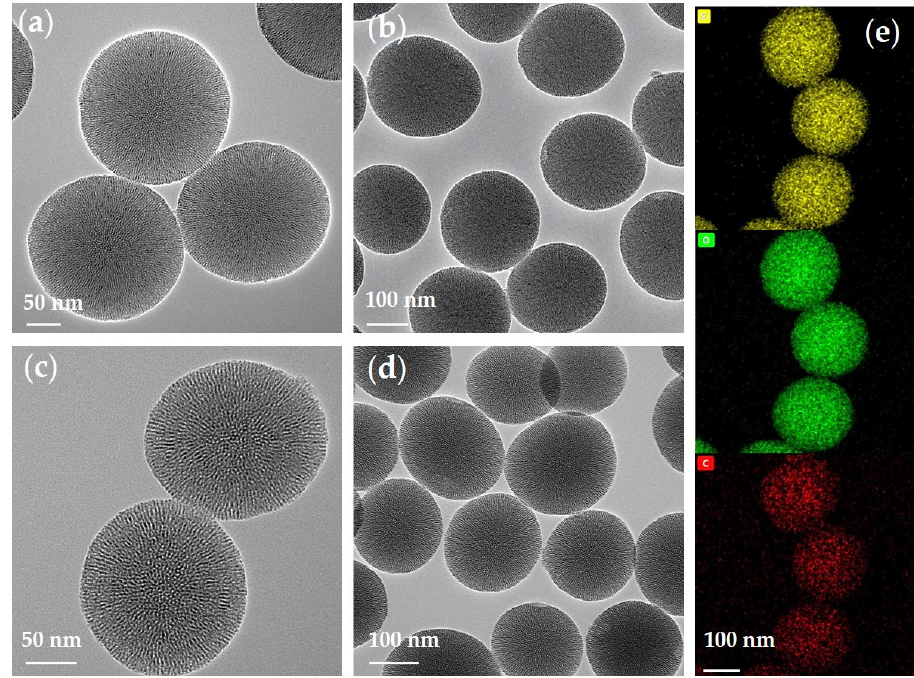
Figure 3 . ( a , b ) TEM images of p-V-SiO 2 . ( c , d ) TEM images of p-SiO 2 . ( e ) Si, O, and C elements in p-V-SiO 2 .